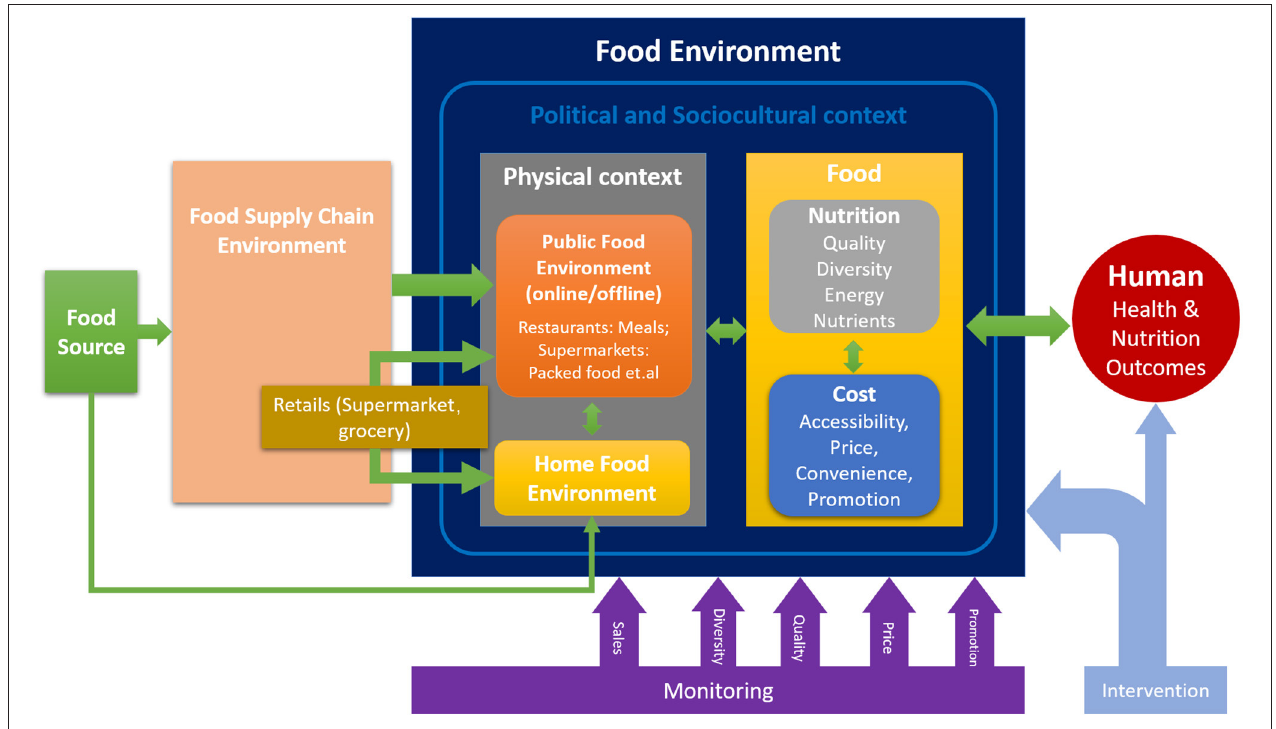
FIGURE 1 | A conceptual framework of the food